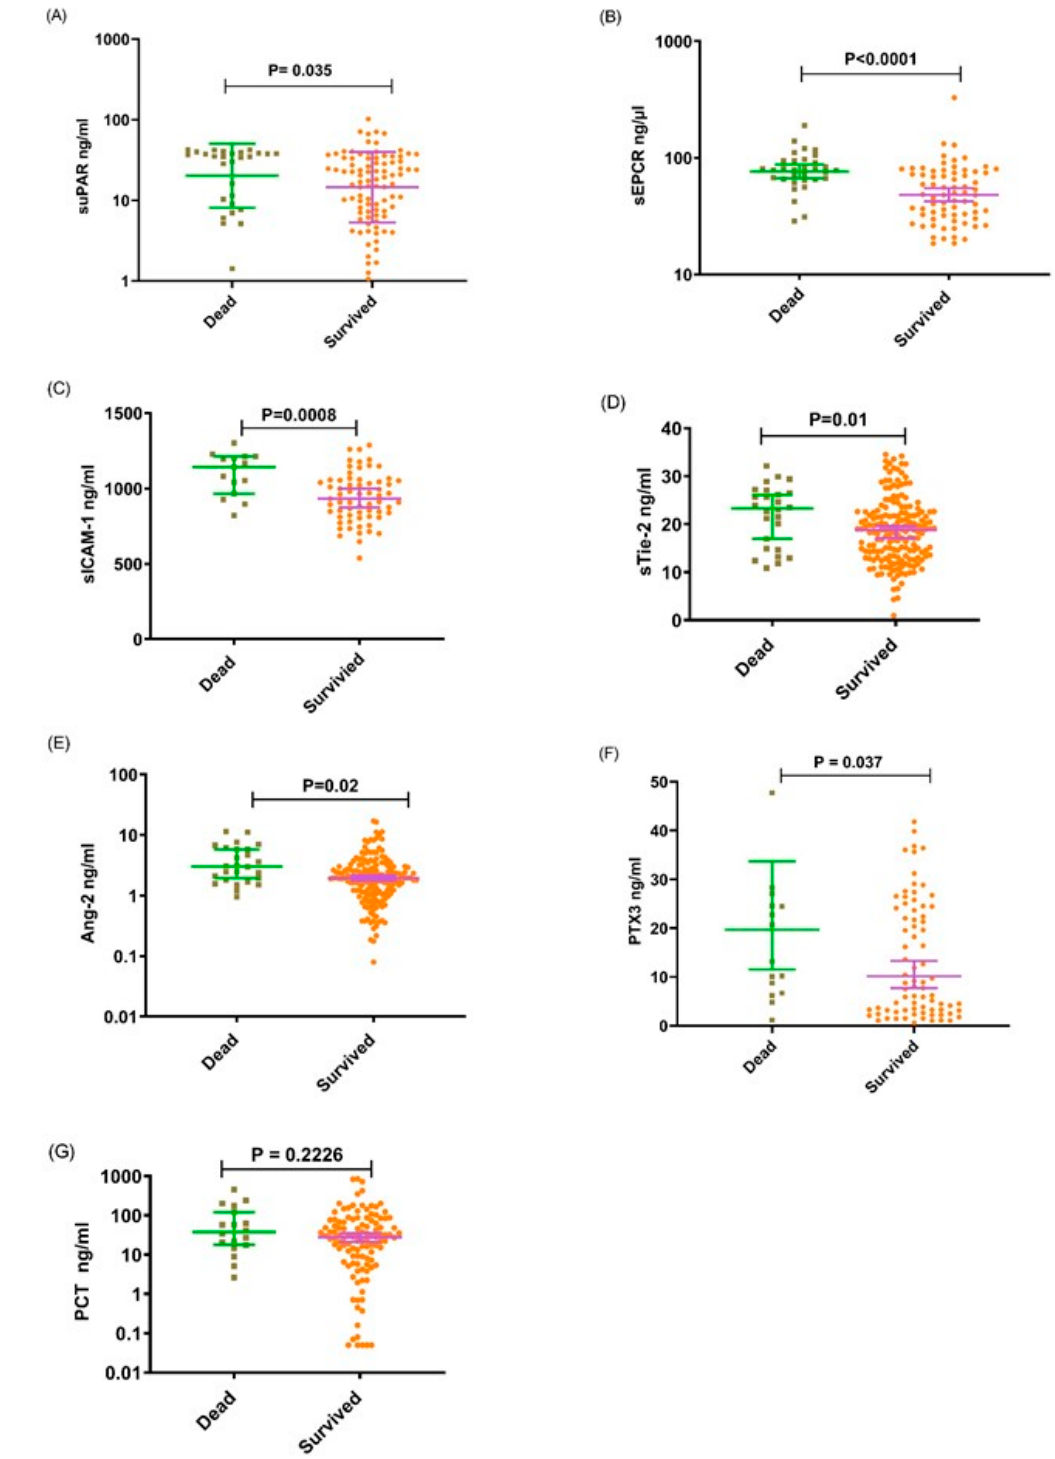
Figure 3. Plasma levels of suPAR, sEPCR, sICAM-1, sTie-2, Ang-2, PTX3 and PCT in children who survived severe non-cerebral malaria or cerebral malaria compared to those who died. ( A – G ), The levels of ( A ) suPAR, ( B ) sEPCR, ( C ) sICAM-1, ( D ) sTie-2, ( E ) Ang-2, ( F ) PTX3 and ( G ) PCT in children who survived severe or cerebral malaria (yellow dots) compared to those who died (gray squares) on the day of admission to hospital as measured by ELISA. Data are presented as dot plots with median and (95% CI). The Mann–Whitney U-test was performed for each comparison.